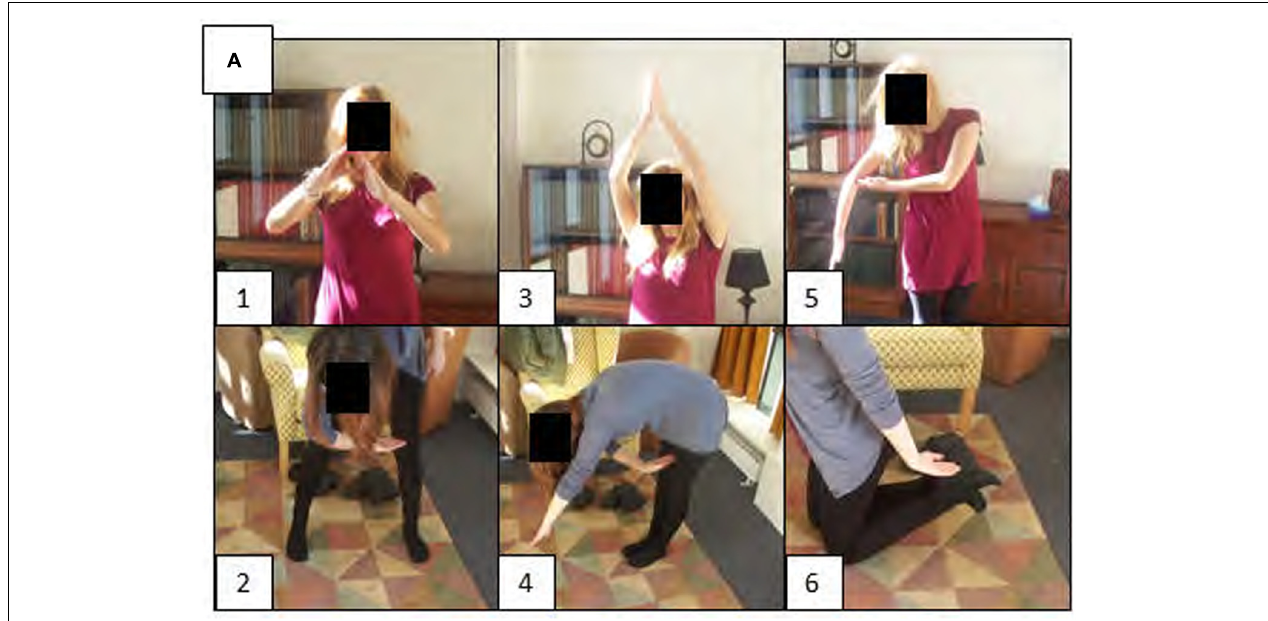
FIGURE 1 | Participants perform actions to represent the shape